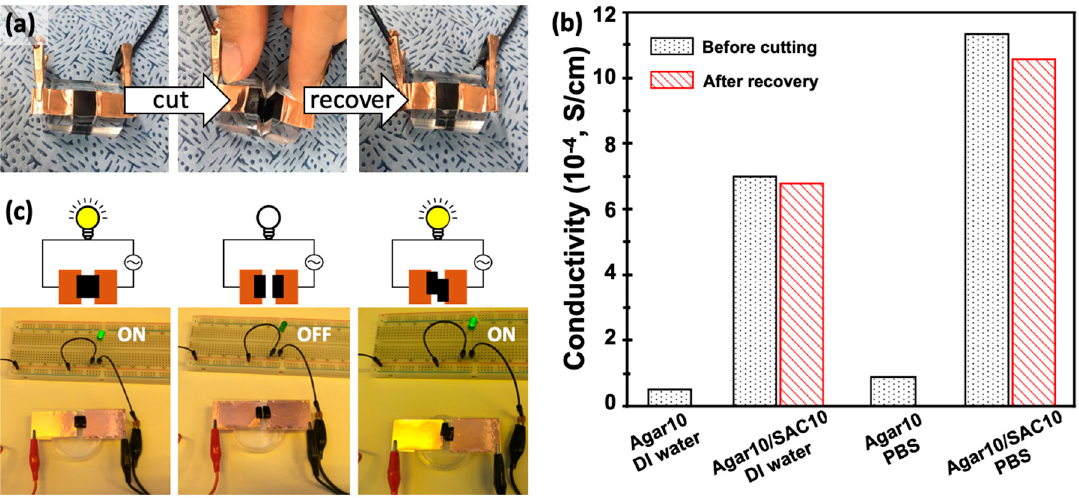
Figure 5. ( a ) Photos of the as-prepared (left), sliced (middle), and recovered (right) 1 cm × 1 cm × 1 cm cubic agar10 / SAC10 composite gels. ( b ) Conductivity of the as-prepared (black dot) and after recovered (red stripe) agar10 / SAC10 composite gels and control samples prepared with DI water or PBS bu ff er, respectively. ( c ) A simple electric circuit connected with the cubic agar10 / SAC10 composite gels and a green light emitting diode (LED). The LED emitted green light when the circuit was connected with the agar10 / SAC10 composite gel (left) whereas it turned o ff (middle) after slicing of the composite gel. Subsequently, the LED light turned back on as the sliced composite gels re-connected with one another, even when poorly aligned (right).